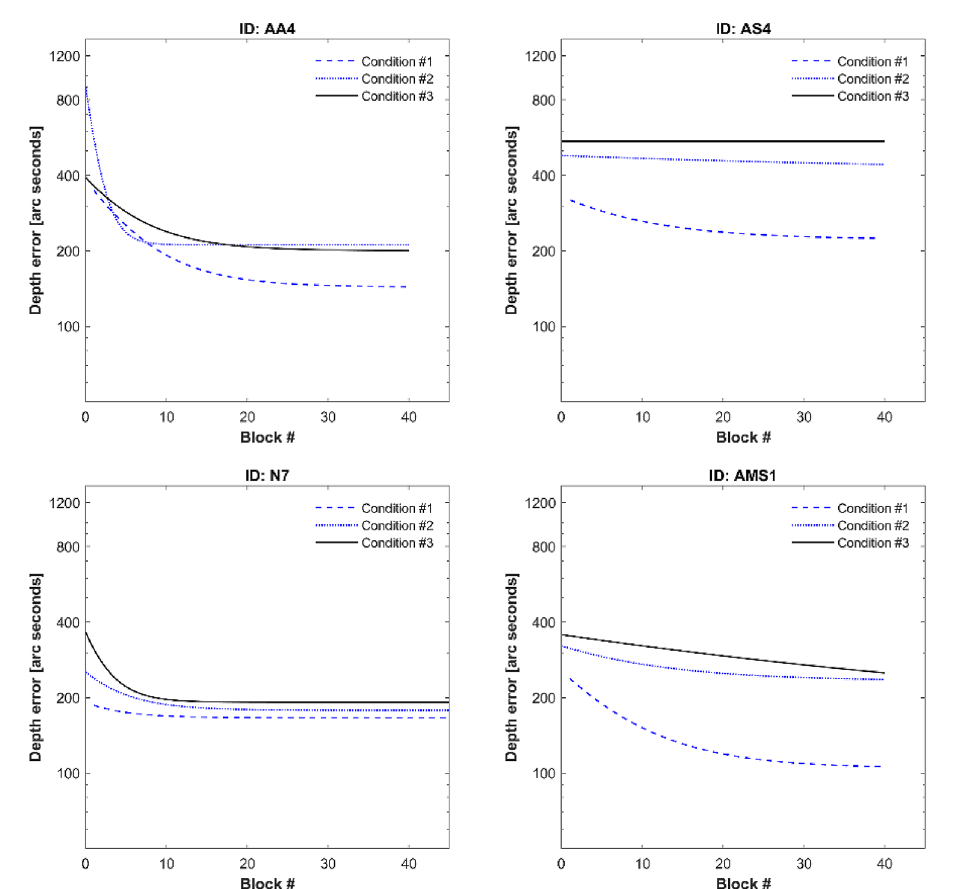
Figure 4. Across-block learning in four participants. From upper left to bottom right: AA4, stereo-anomalous anisometric; AS4, stereo-anomalous strabismic; N7, stereo-normal; AMS1, stereo-anomalous with micro strabismus. Each graph shows the exponential fit of the end-block depth error in the three conditions: Condition 1, blue dashed line; Condition 2, blue dotted line; Condition 3, dark continuous line. Although N7 performed 60 blocks of training, only first 45 blocks are represented to facilitate